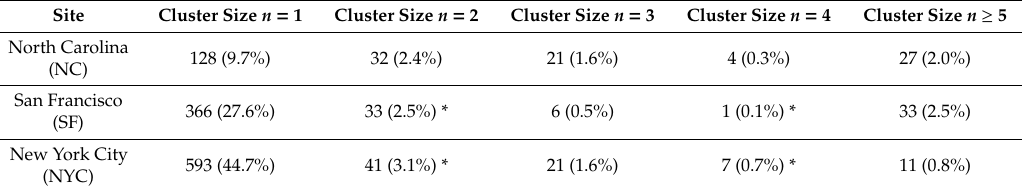
Table 2. Distribution of HIV cluster sizes by study site (NC, SF, NYC).